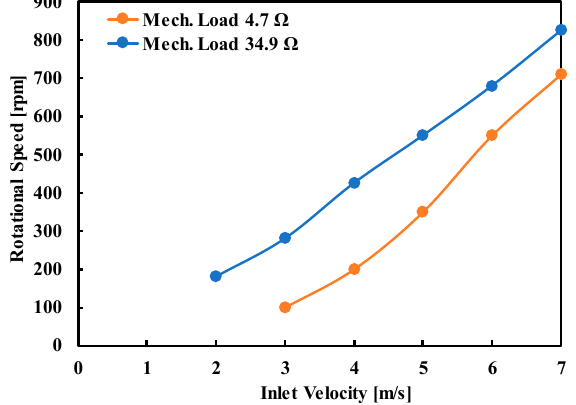
Figure 20. Power at different inlet velocity: ( a ) Mechanical Load; ( b ) Electrical Load.